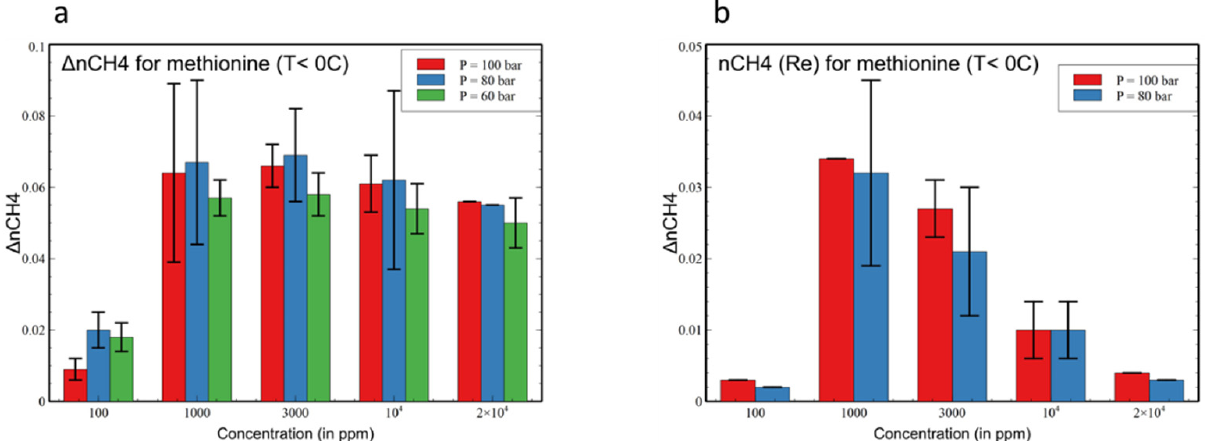
Figure 14. Effect of temperature decrease from 1 °C to − 2 °C on the CH 4 uptake in hydrate (in the presence of methionine) (refer ( a )) for three different starting pressures (60, 80 and 100 bar). ( b ) shows CH 4 (R) number (for five different concentrations of methionine) at three different pressures (60, 80 and 100 bar) at T = − 2 °C.